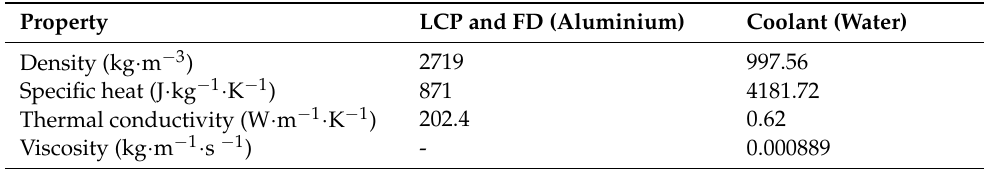
Table 3. Physical properties of LCP, flow distributor (FD) and coolant.